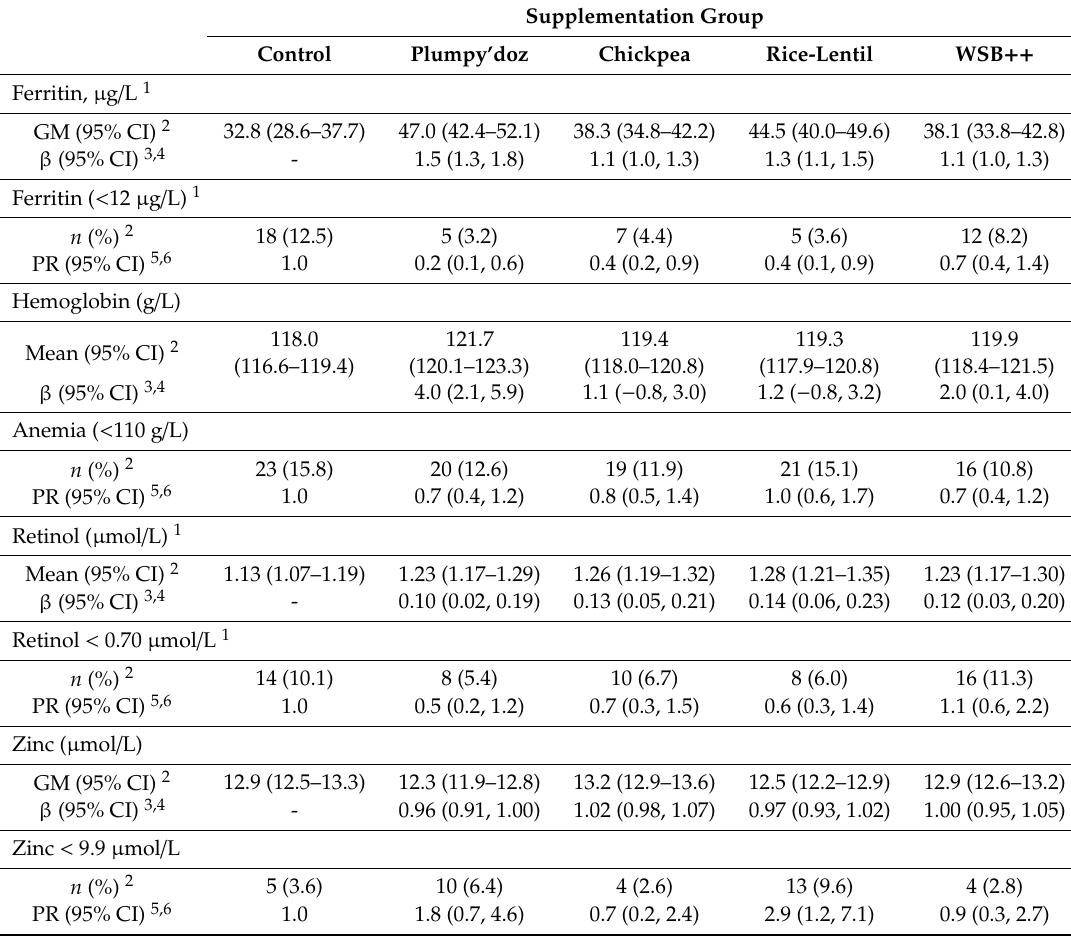
Table 4. Micronutrient status indicators and modeled di ff erences and prevalence ratios by supplementation group at age 18 months following one year of participation in a complementary food supplementation trial in rural